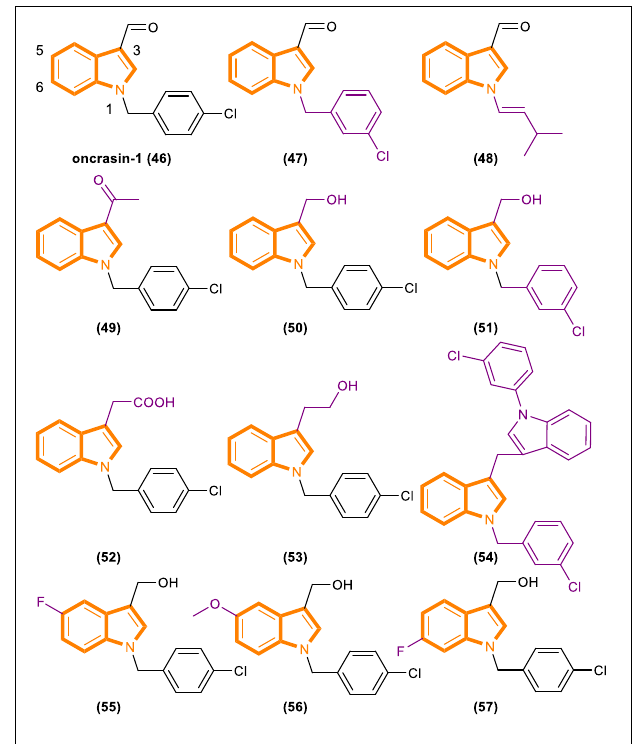
FIGURE 10 | Oncrasin-1 and its analogs (46–57).